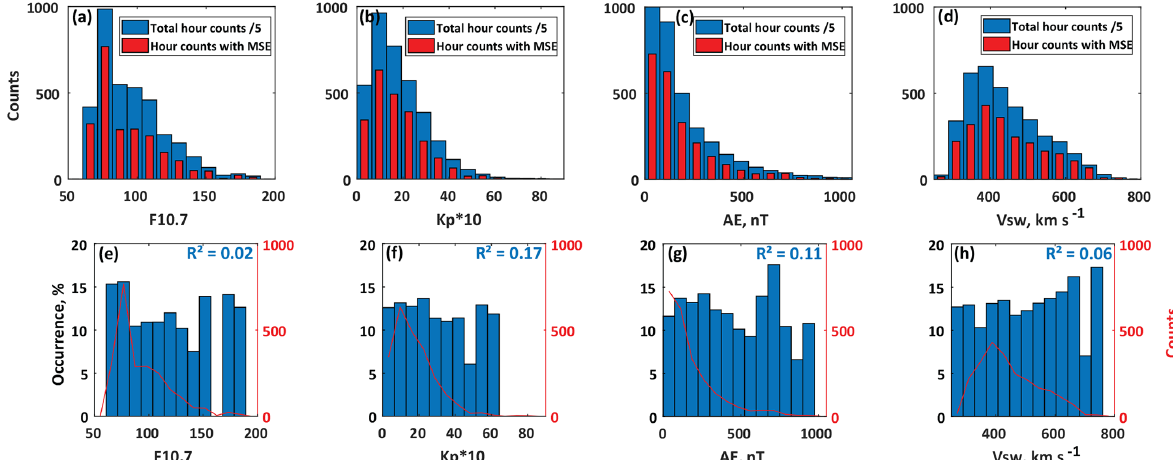
Figure 5. Dependencies of MSEs on solar and geomagnetic activity, manifested by 10.7cm solar radio flux F10.7 in solar flux units (a, e) , planetary 3h range index Kp (b, f) , auroral electrojet index AE (c, g) , and solar wind speed V sw (d, h) . In the top row (a–d) , the total counts of OSWIN observation hours are shown by blue bars, and the counts of hours with MSEs detected are shown by red bars (note that the number of total counts is divided by a factor of 5). In the bottom row (e–h) , the occurrences of MSEs in each bin of the solar or geomagnetic indices are shown by blue bars, and the red lines indicate the number of counts with MSEs detected. Correlation coefficients between the occurrence of MSEs and solar or geomagnetic indices are shown by blue